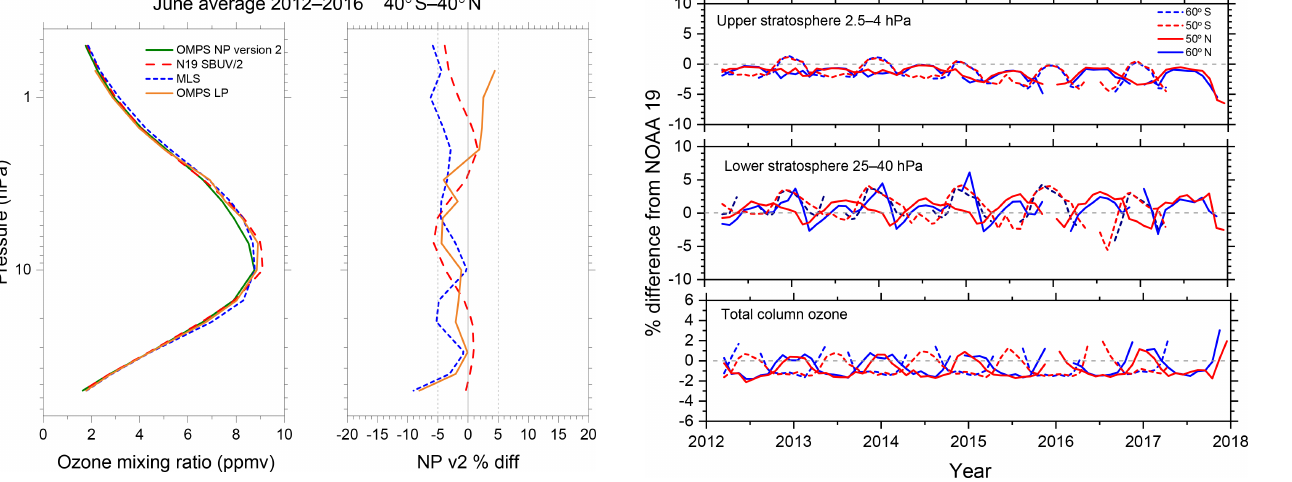
Figure 11. The time dependence of the version 2.0 ozone anomaly relative to NOAA 19 shown for high